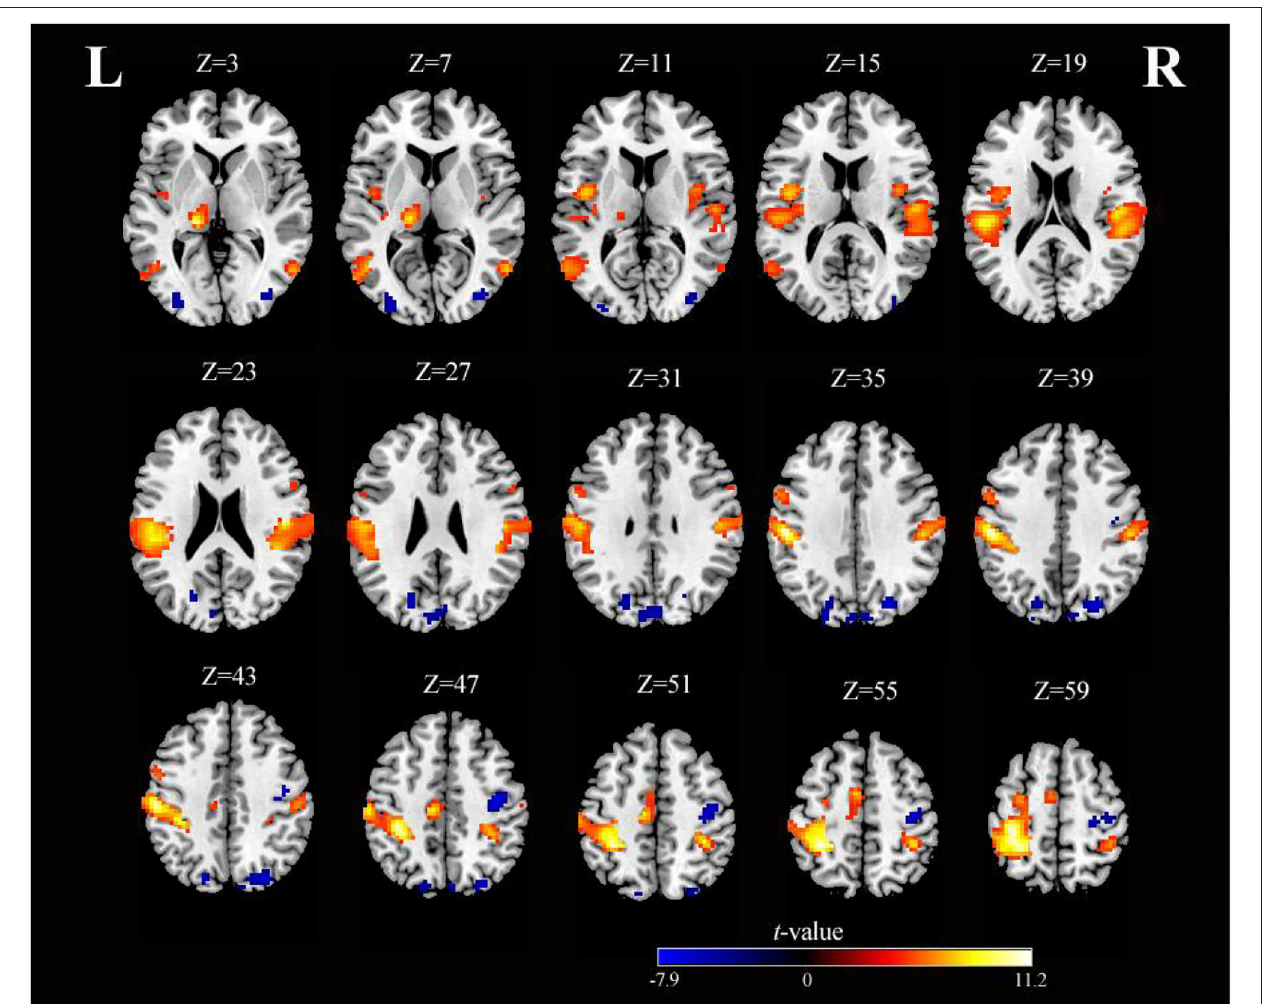
FIGURE 3 | Axial slices with corresponding Z-coordinates (MNI) from the t -value map of SS (voxel-level, FDR-corrected p < 0.001, cluster size > 10 voxels). MNI, Montreal Neurological Institute; SS, somatosensory stimulation; FDR, false discovery rate; L, left; R, right .